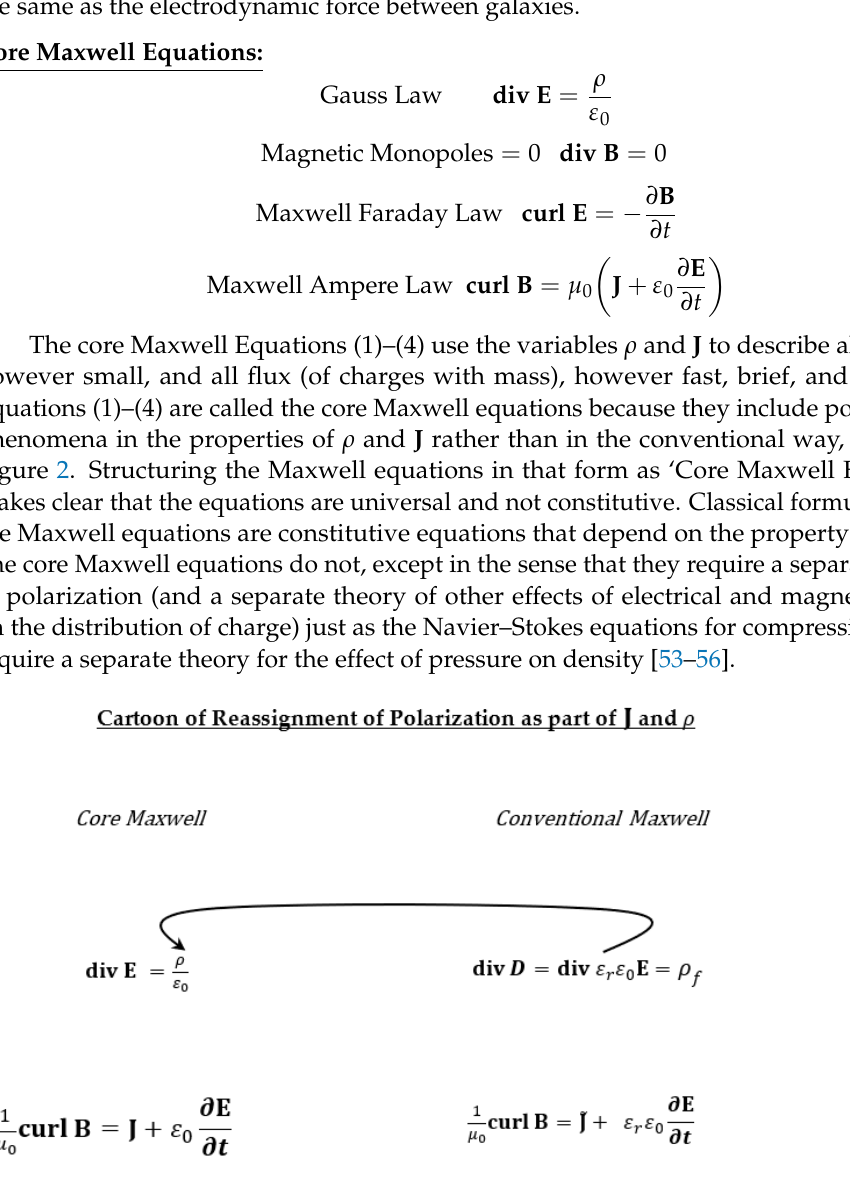
Figure 1. The need for electrodynamics, not just electrostatics, is emphasized by Feynman, in lan- guage that could hardly be more explicit. See volume 2 of [4].